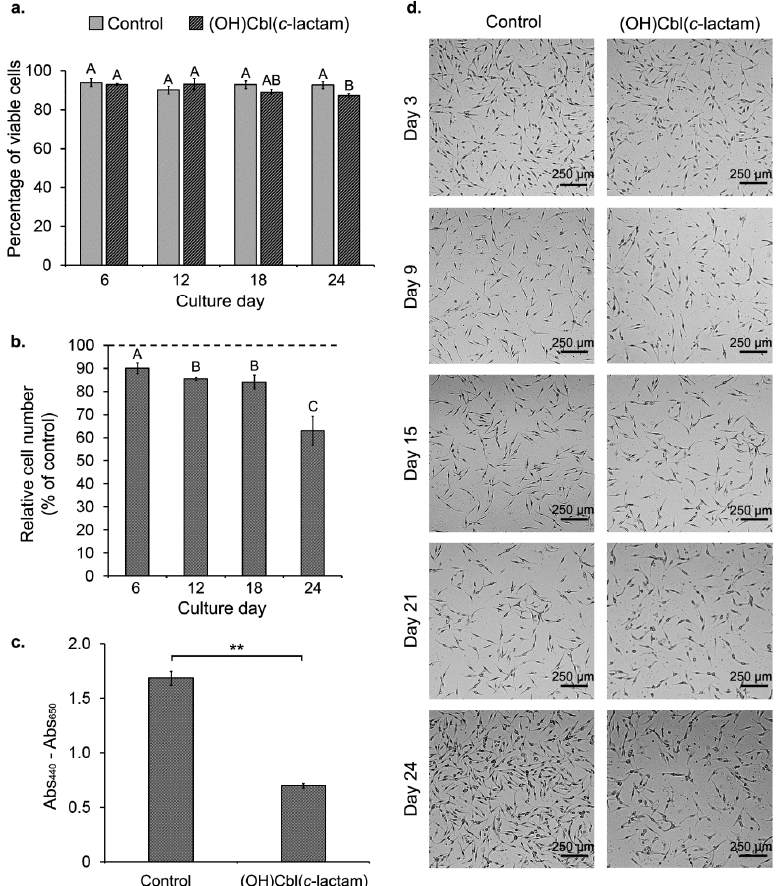
Figure 2. Effect of long-term incubation with (OH)Cbl( c -lactam) on melanocytes viability and proliferation. HEMn-DP cells were cultured in medium supplemented with (OH)Cbl( c -lactam) in concentration of 10 µ g/mL for 24 days. Control melanocytes were cultured in parallel in growth medium. ( a ) The percentage of viable cells in total cell population for both treated and control